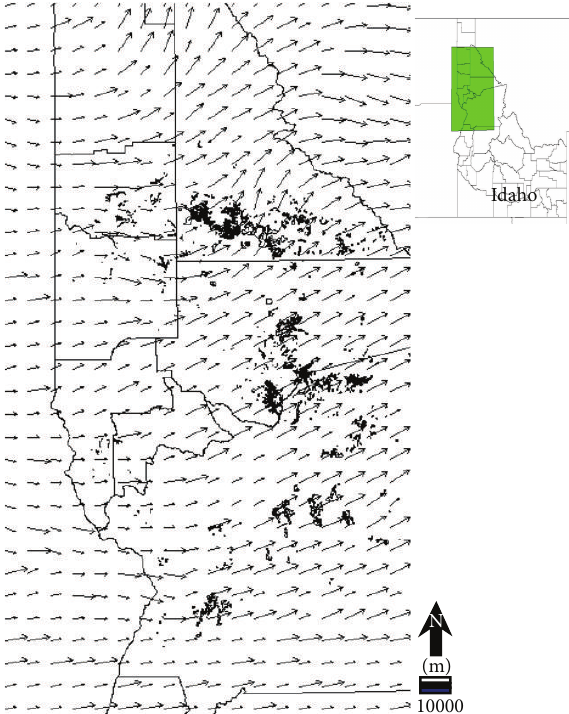
Figure 3: August wind plot indicating direction and force in north central Idaho. 1995 balsam woolly adelgid infestations are in